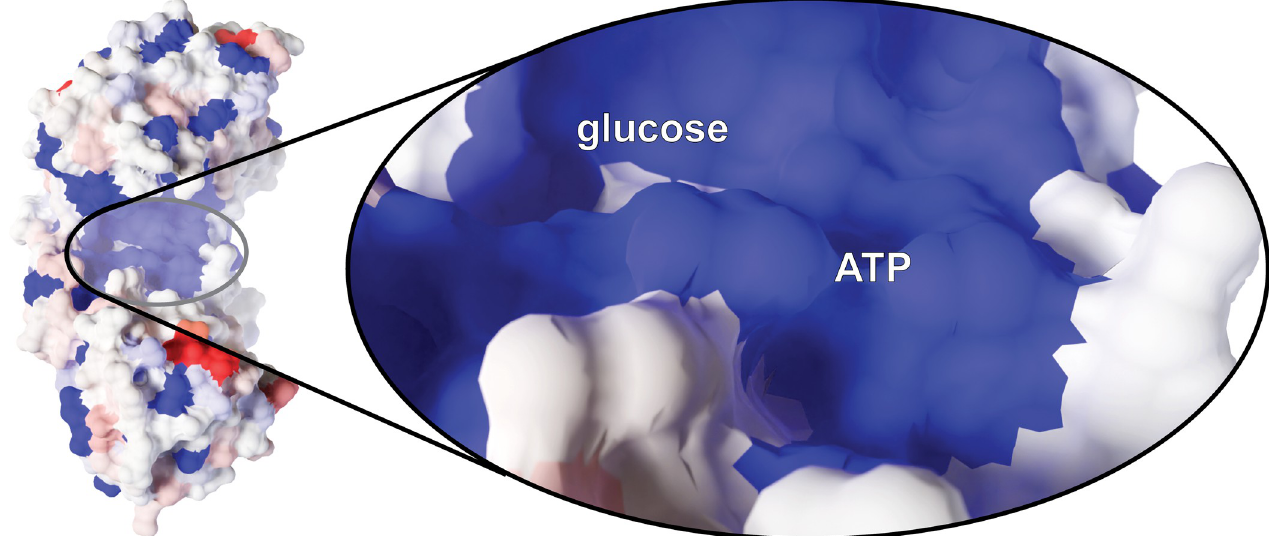
Fig 9. Residue similarity between Sc Hxk2 (yeast) and Hs Hk2 (human). Similarity is projected onto a structure of Sc Hxk2 (PDB 1IG8) and colored per the BLOSUM30 scoring matrix. Highly similar amino acids are shown in blue, and dissimilar amino acids are shown in red.